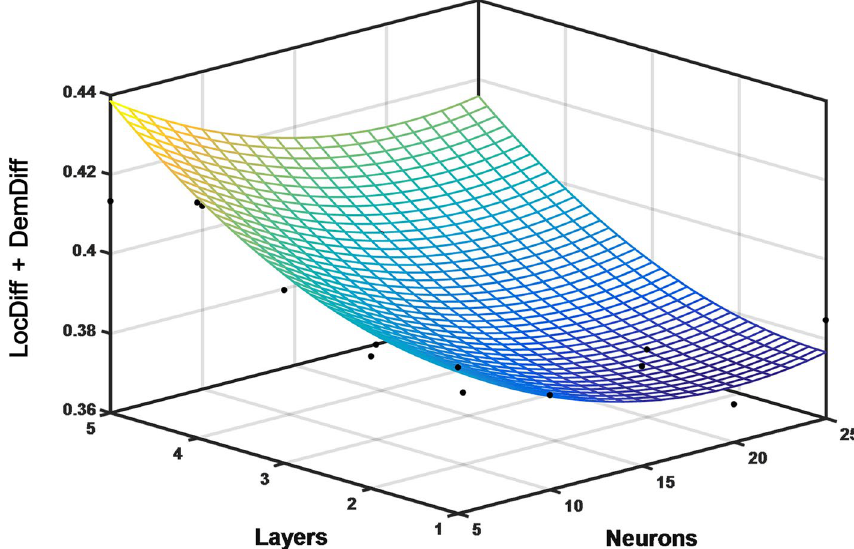
Fig. 3 Grid-search results based on model effectiveness for the number of neural network layers and neurons in each